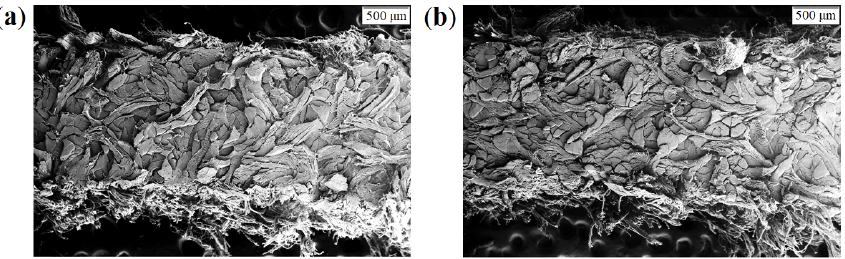
Figure 2. Electron microscopic images (secondary electron signal) of split leather samples from back parts: ( a ) Simmental breed leather L1 and ( b ) zebu breed leather L3.